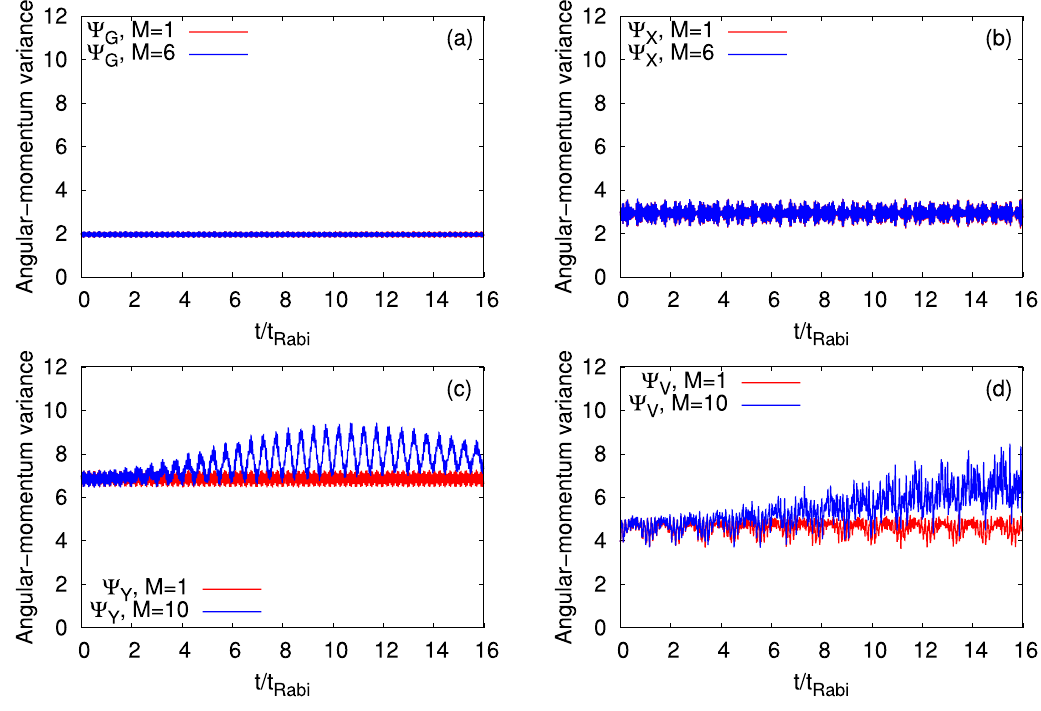
1 � 2 ( t ) , in a symmetric 2D double-well Figure 9. Dynamics of the angular-momentum variance per particle, N ˆ L Z 10 bosons. The interaction parameter for the initial states ( a ) (cid:31) G , ( b ) (cid:31) X , ( c ) (cid:31) Y , and ( d ) (cid:31) V with N = 0.01 π . Mean-field ( M 1 time-adaptive orbitals) results are presented in red and corresponding many- � = = 6 time-adaptive orbitals for (cid:31) body results are shown in blue. MCTDHB results are computed with M = 10 time-adaptive orbitals for (cid:31) (cid:31) X , and M Y and (cid:31) V . See the text for more details. The quantities shown are =